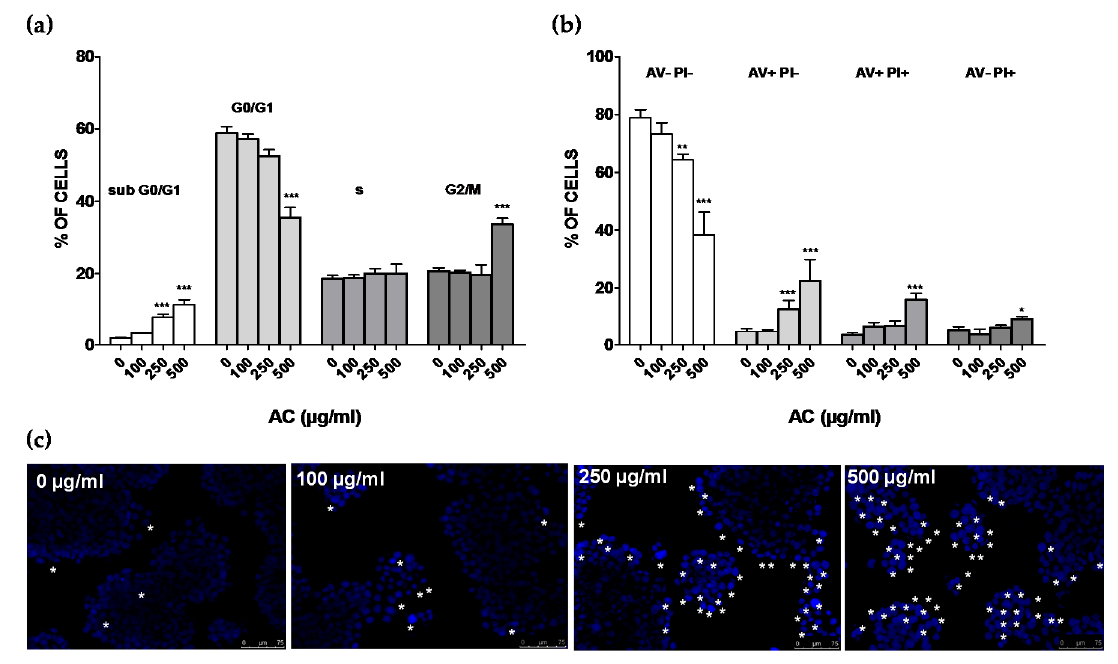
Figure 3. ( a ). Acacia catechu Willd. extract (AC)-mediated effects on the human colorectal adenocarcinoma HT-29 cell cycle. Percentages of cells in subG0/G1, G0/G1, s and G2/M phases. ( b ). Apoptotic cells’ detection by double staining with annexin V (AV) and propidium iodide (PI). Values are means ± SEMs of four or five independent experiments in which four points/concentrations were run; controls (AC 0 µg/mL) represent untreated cells. * p < 0.05, ** p < 0.01, *** p < 0.001 vs. controls (ANOVA followed by Dunnett post-test). ( c ). DNA condensation and damage assessed by DAPI staining. Asterisks indicate cells with fragmented nuclei and condensed DNA, considered apoptotic. Each photograph was representative of three independent observations (scale bar 75 µm).